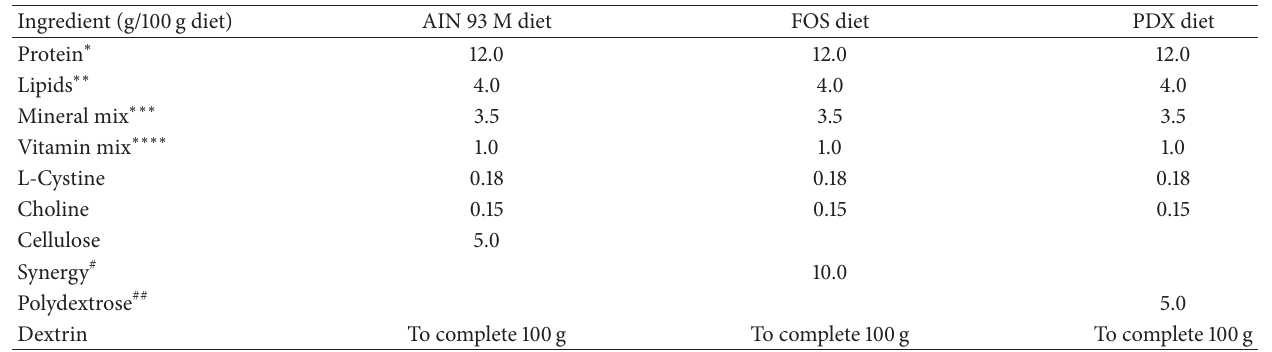
Table 1: Composition of the experimental diets.